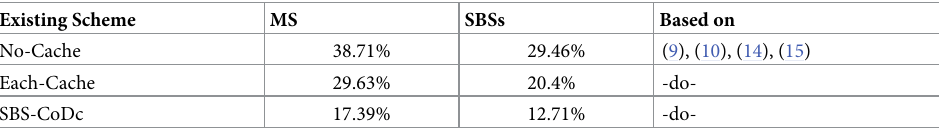
Table 4. Percentage improvement of average EC of MSs and